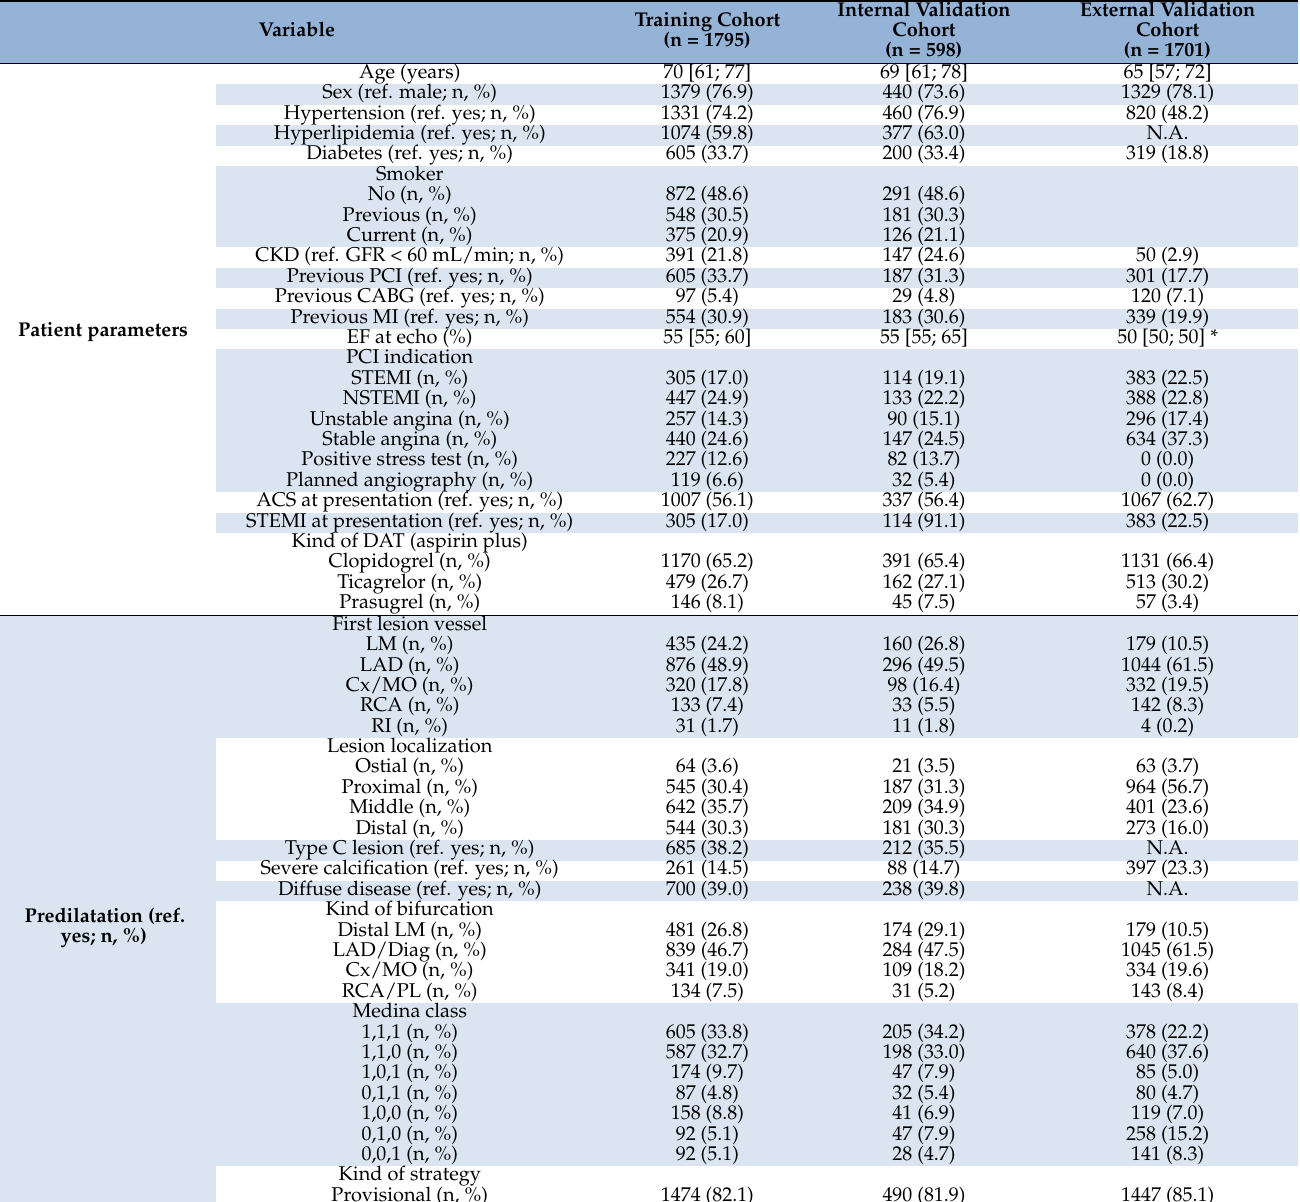
Table 1. Clinical, anatomical, procedural features and outcomes in the study